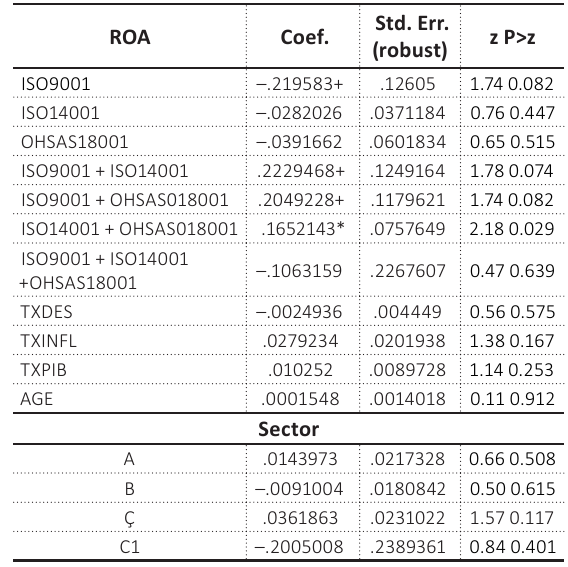
Table 9. Results of the regression model for the multiple